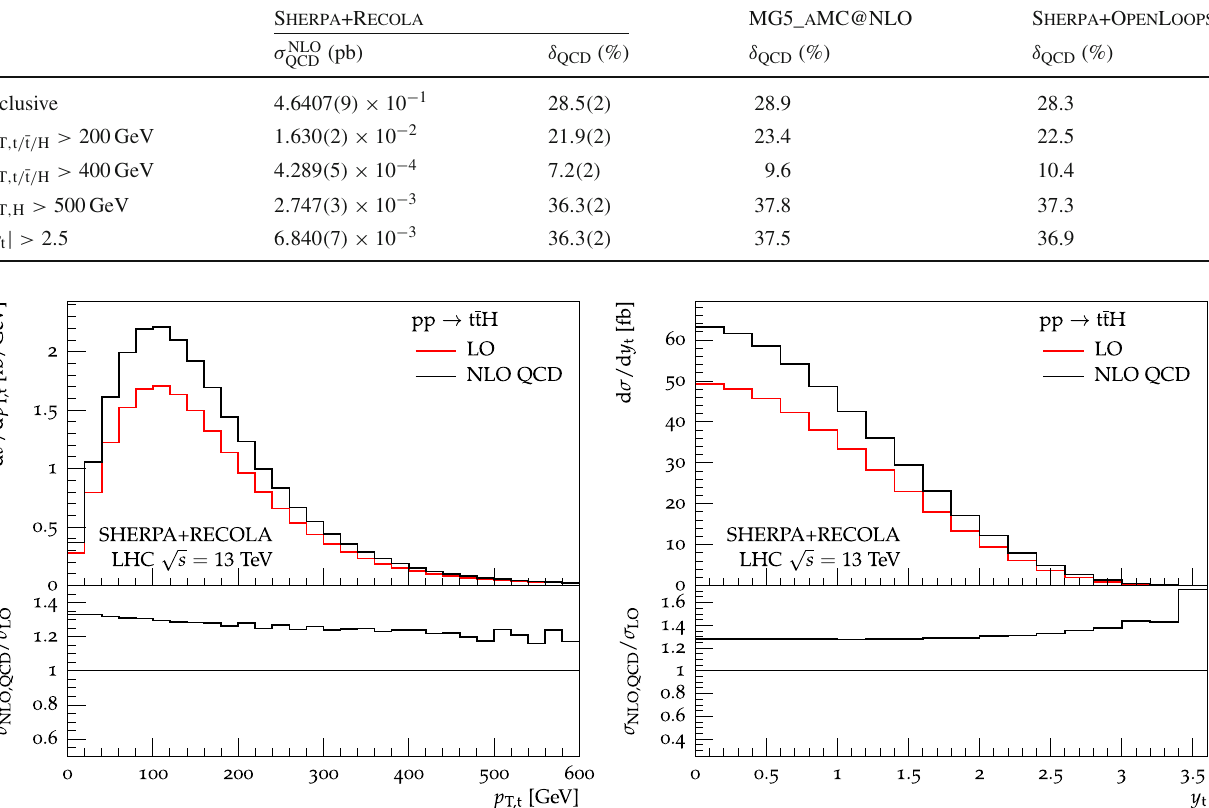
Table 6 Integrated cross sections for pp → t ¯ tH at NLO QCD for a Ref. [68]. The cross sections are expressed in pb while the relative cor- √ s = 13TeV calculatedwith Sherpa + Recola , centre-of-mass energy rectionsareexpressedinpercent.Theintegrationerrorsofthelastdigits MadGraph5_aMC@NLO , and Sherpa +O pen L oops for the set-up of are given in parentheses for the Sherpa + Recola predictions